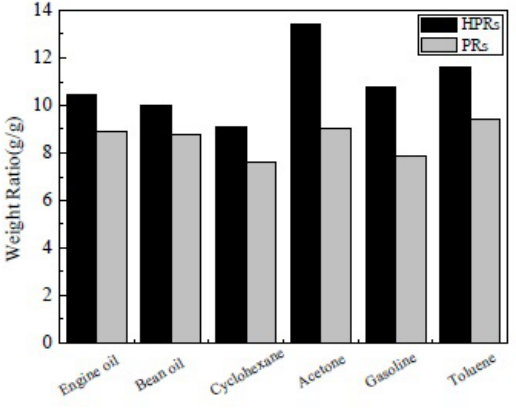
Figure 9: The oil adsorption rate of PRs and HPRs for different oils